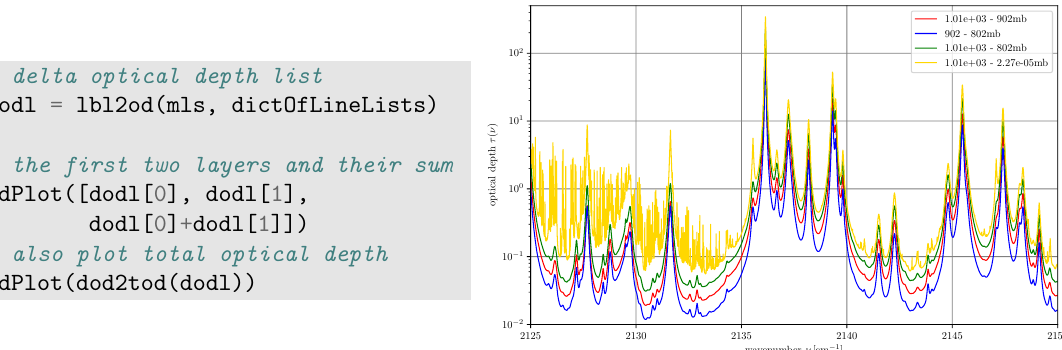
Figure 5. Computing and combining optical depths.